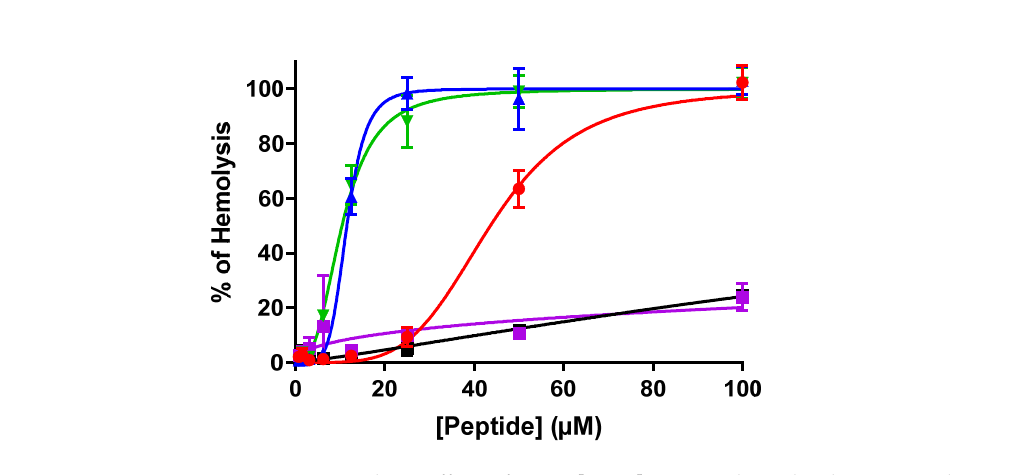
Figure 9. Hemolytic effect of SHa, [G10a]-SHa and its dendrimers on human red blood cells. Hemolysis was measured in the presence of increasing concentrations of SHa (black squares), [G10a]-SHa (red circles), [G10a] 2 -SHa (blue triangles), [G10a] 3 -SHa (green inverted triangles) or Jeff-[G10a] 2 -SHa (purple squares). Hemolysis was expressed in percentage of Triton X-100 0.1% being used as positive control giving 100% hemolysis (means ± SD, n = 3). Curves were fitted using GraphPad ® Prism 7 software.